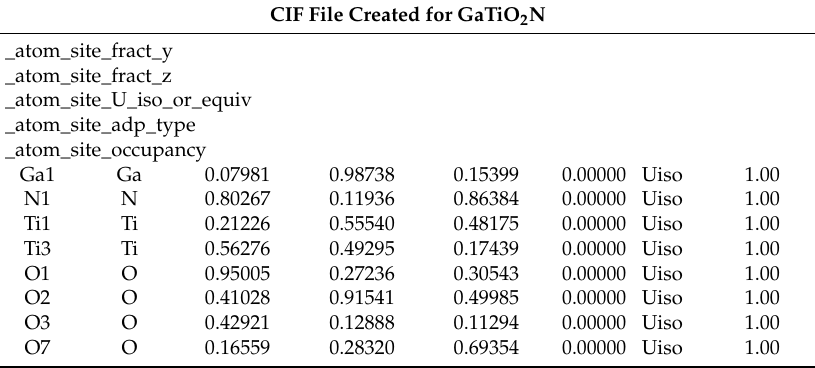
CIF File Created for GaTiO 2